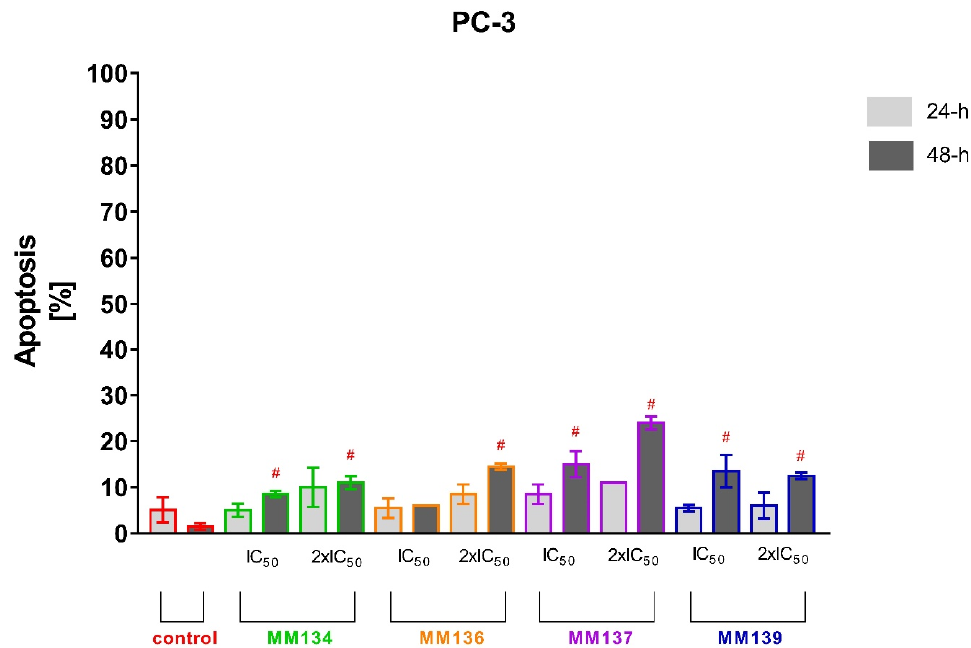
Figure 9. Determination of apoptosis induction in PC-3 cell line treated with IC 50 and 2xIC 50 concen- trations of MM-compounds measured with AO/EB double staining following 24 and 48 h incubation time. Data are presented as mean percentage of apoptotic cells (early and late apoptotic) ± SD values. The differences between the experimental samples and vehicle control were evaluated by the ANOVA test followed by Tukey’s test ( p < 0.05). # significant difference compared to the negative control (48 h incubation time); p < 0.05; N = 200.